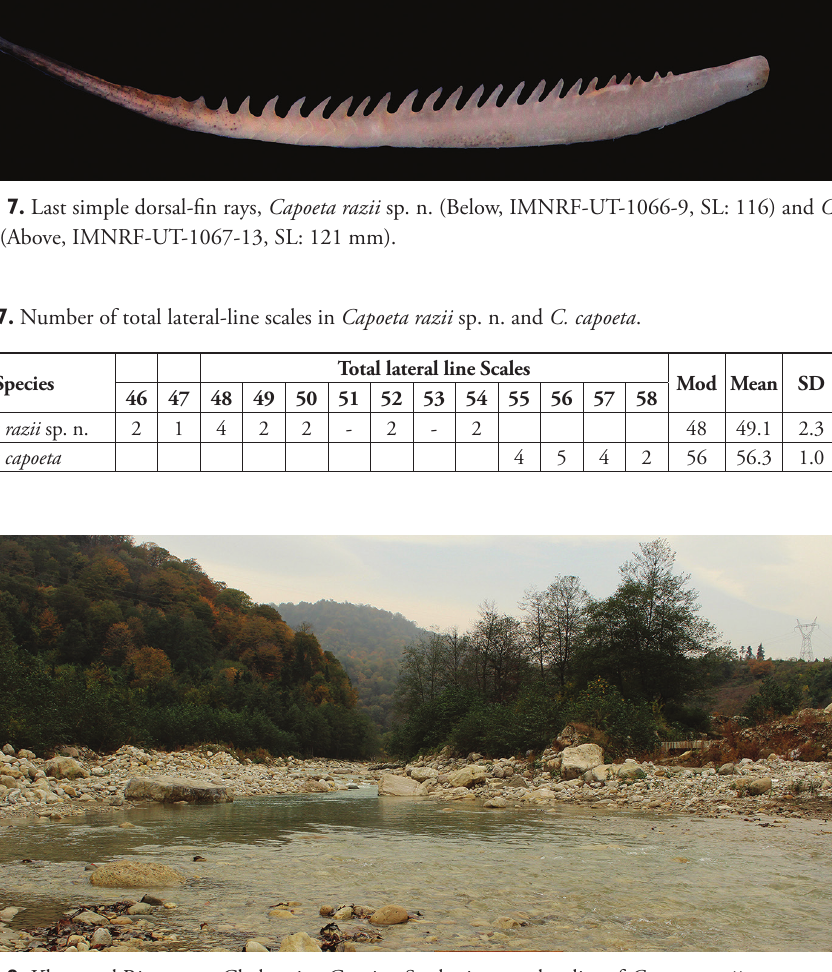
Figure 8. Kheyroud River, near Chalos city, Caspian Sea basin, type locality of Capoeta razii sp. n. Colouration. In life, the upper part of the body is golden brown, olive-green, or silver, and the belly is whitish up to the lateral line. The head is dark-brown or olive- green on top and the cheeks are pale brown to white (Figure 4). Anal, pelvic, and pec- toral fins are hyaline or light brown, and dorsal and caudal fins have a narrow black line on rays. In specimen smaller than 50 mm SL, minute black spots are present on